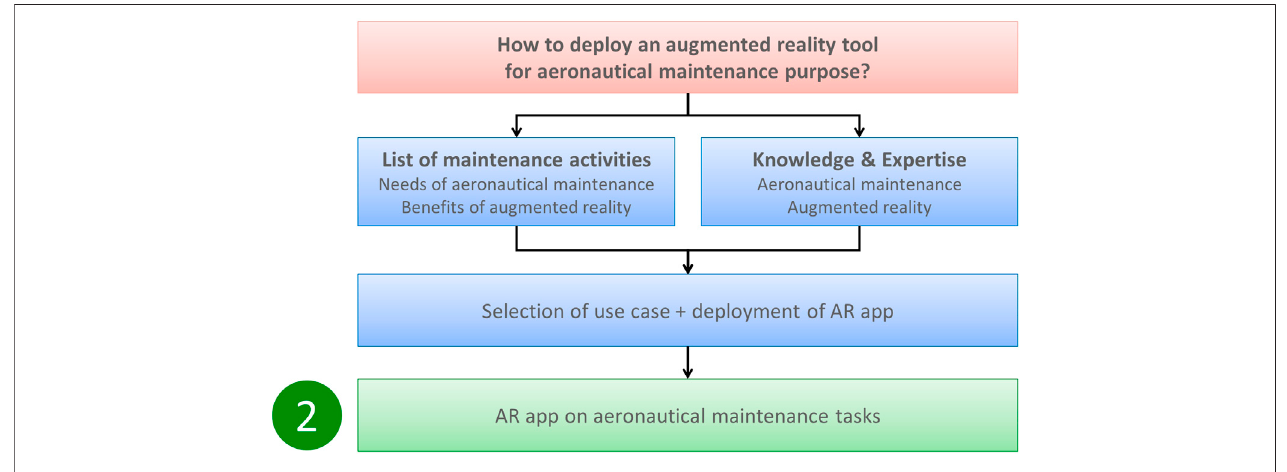
FIGURE 5 | Methodology to deploy an AR tool to assist aeronautical maintenance